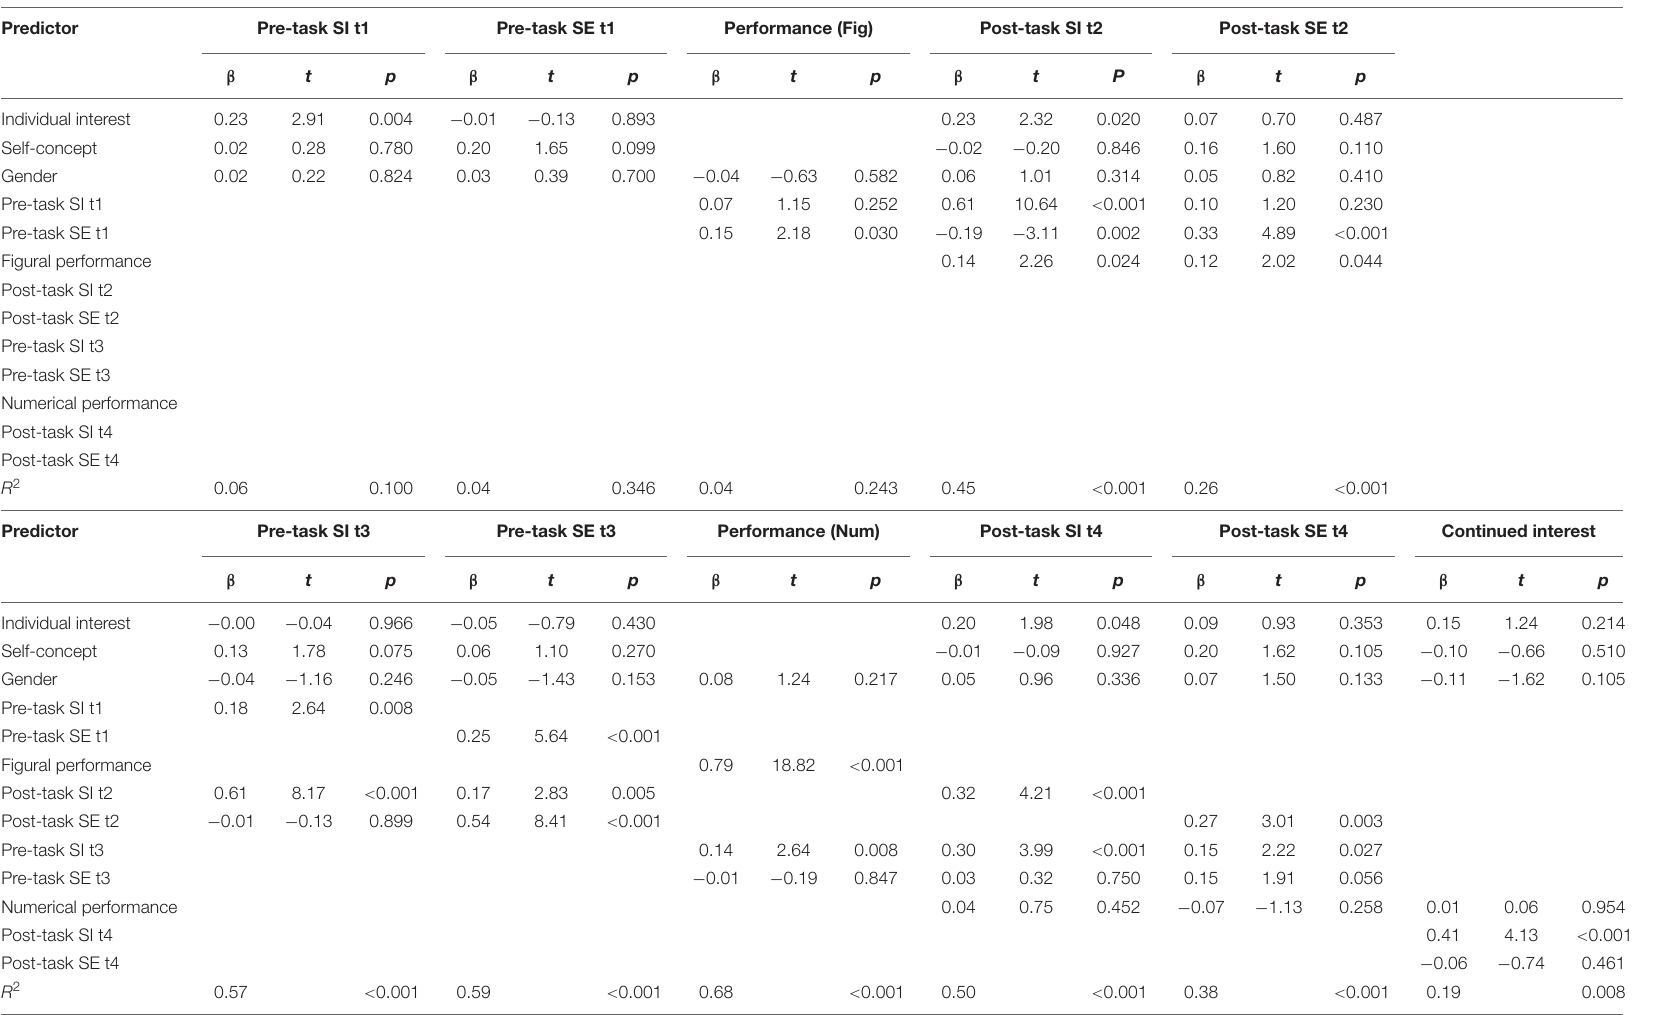
TABLE 2 | Standardized predictive effects from the empirical model.